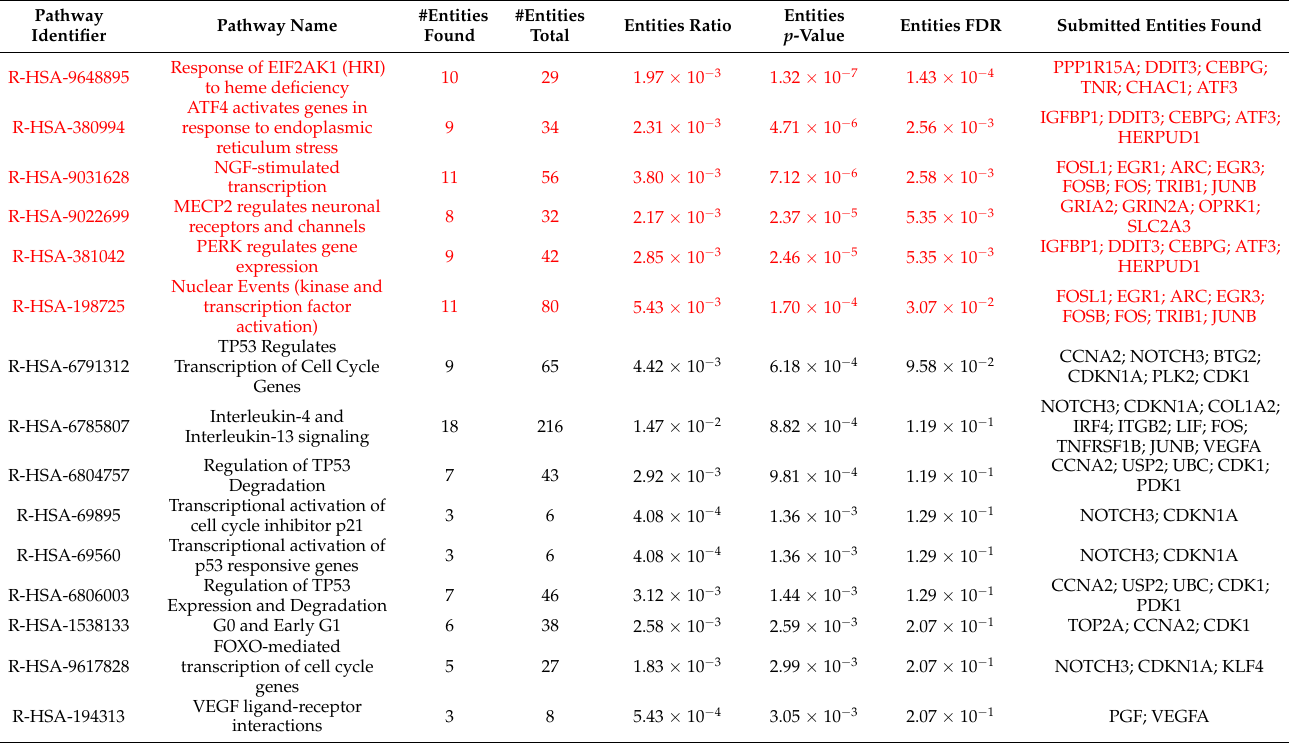
have an FDR less than 0.05, which could be clustered in the events of “Extracellular matrix organization” (including “Extracellular matrix organization”, “Collagen biosynthesis and modifying enzymes”, “Collagen chain trimerization”, “Collagen formation”, “Assembly of collagen fibrils and other multimeric structures”, “Collagen degradation”, “ECM proteogly- cans”, “Integrin cell surface interactions”, and “Anchoring fibril formation”), “Hemostasis” (including “Dissolution of Fibrin Clot”, “GP1b-IX-V activation signaling”, “Platelet Aggre- gation (Plug Formation)”, and “Platelet Adhesion to exposed collagen”), and “Disease” (including “Diseases of glycosylation”) (Table 5). These results further validate male and female cartilage differences at the molecular event level in response to OA. Table 3. The top 15 pathways enriched from the OA-responsive DEGs in male cartilage. Pathways with an FDR less than 0.05 are highlighted in red.